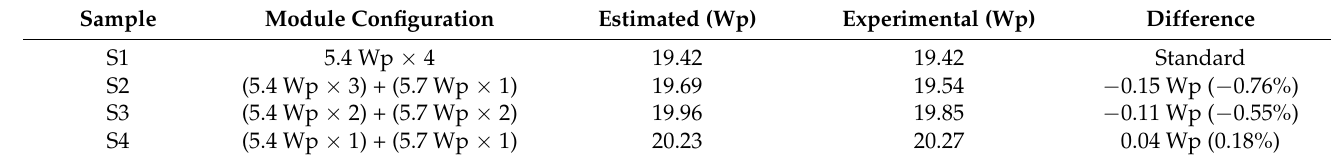
Table 6. The difference between the estimated and the experimental values of the samples S1–S4.